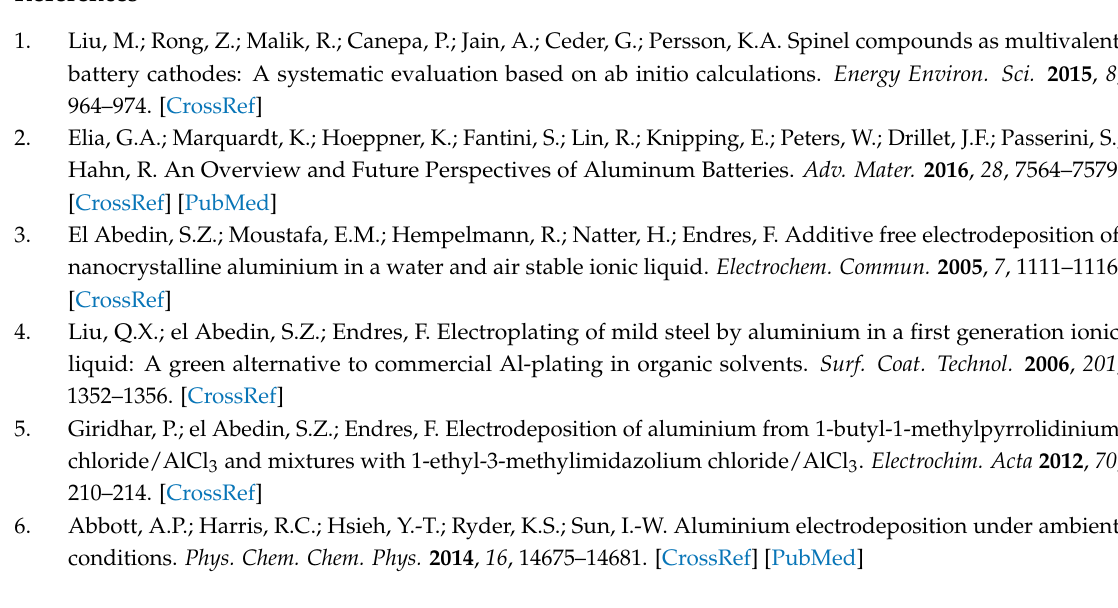
Figure A2. XRD diffraction pattern of MnO 2 before and after TGA treatment. K-birnessite (PDF 00-080-1098 = *) and hausmannite (PDF 00-024-0734 = #) are shown as references.